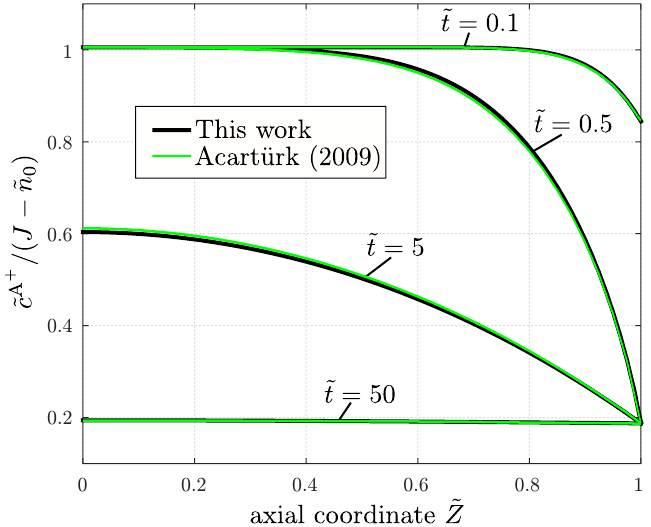
Figure A3. Comparison of the results for the cation concentration along the axial coordinate ˜ Z at different times